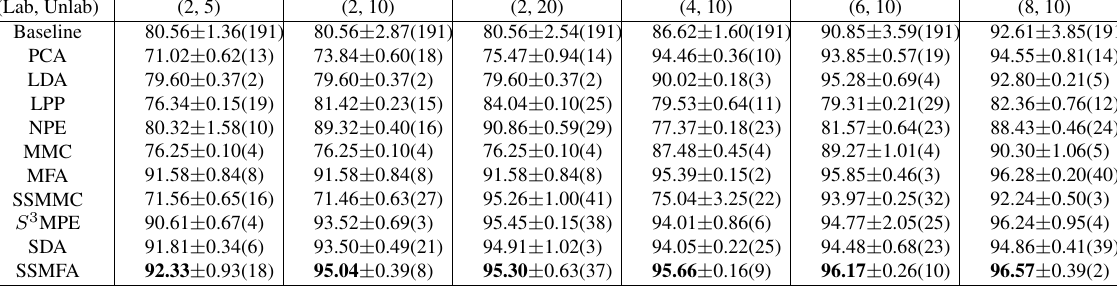
Table 2: Comparison of different methods for Washington DC Mall data set ( mean + std ( dim